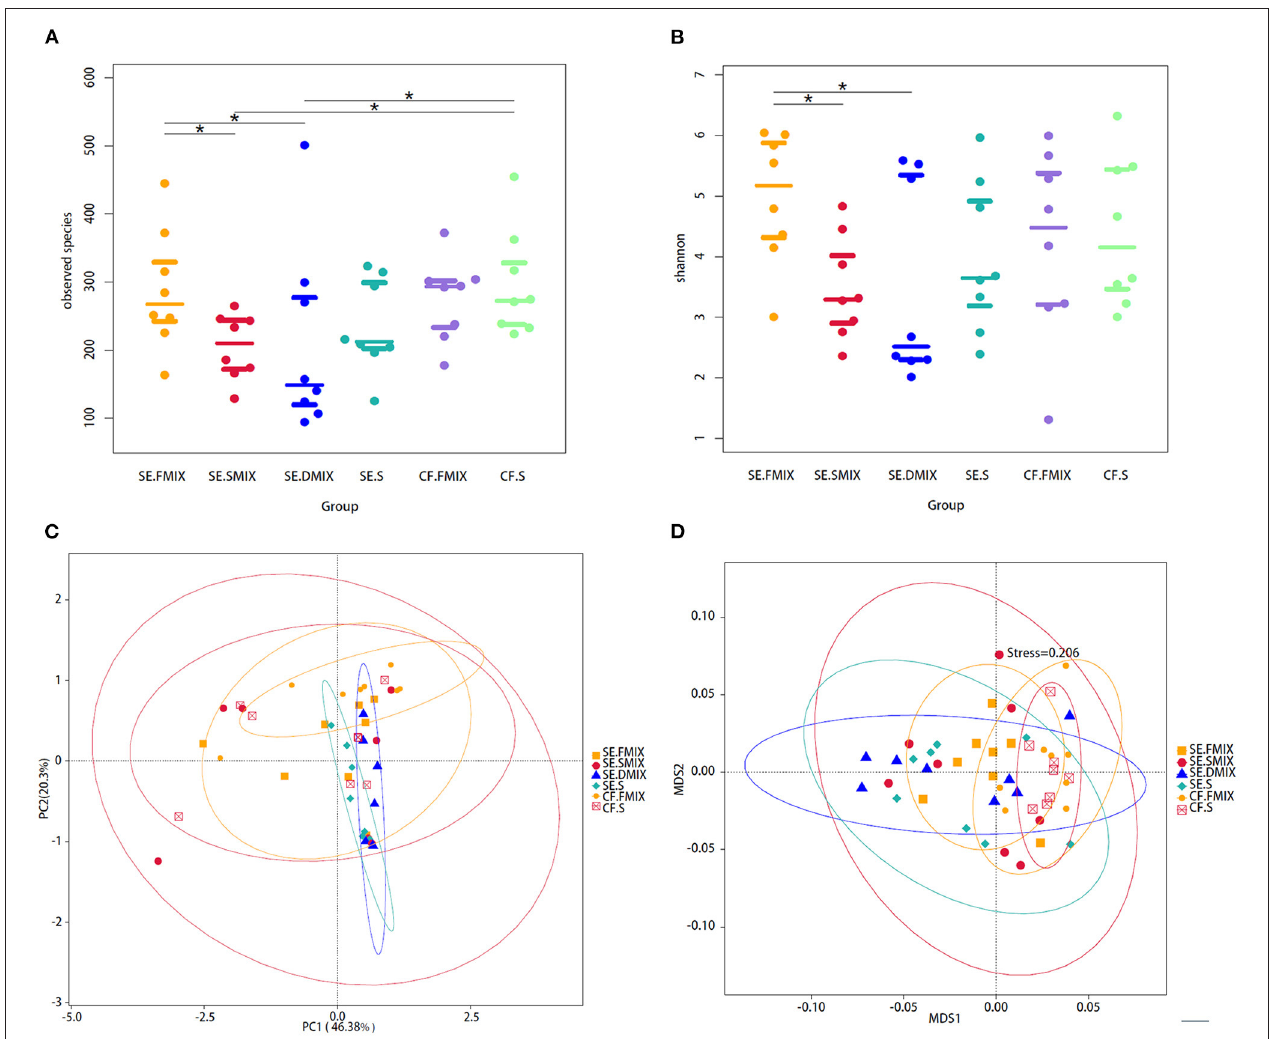
FIGURE 1 | Alpha and beta diversity analyses among the six categories. (A) Observed species and (B) Shannon diversity in various spatial niches with and without S-ECC. *Represents significant differences ( P < 0.05) between two categories. (C) Principal coordinate analysis and (D) non-metric multidimensional scaling plot based on taxa abundance in each sample. Each point in figures represents a sample and samples of the same category are represented by the same color.